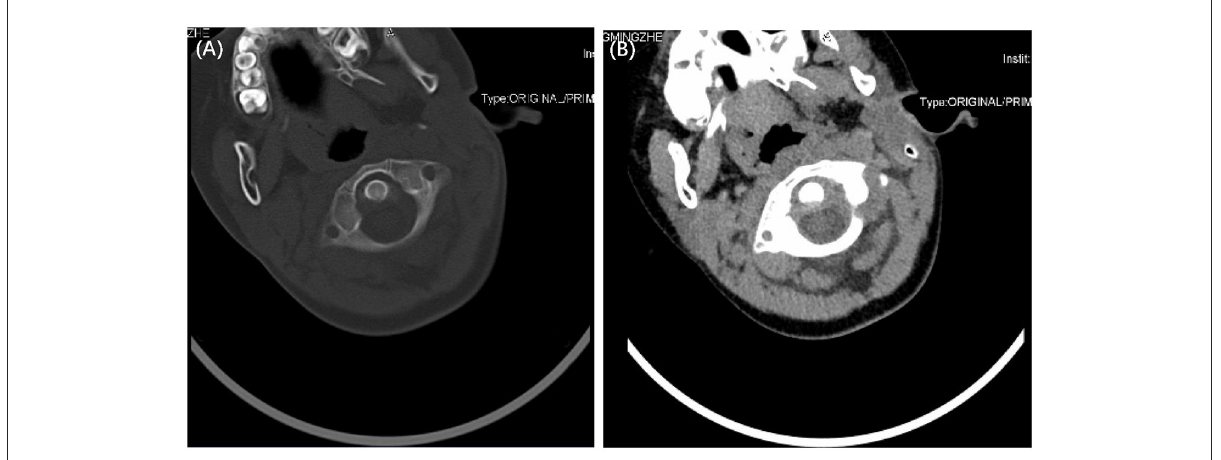
FIGURE1 A computed tomography scanning showed Type I atlantoaxial joint subluxation (A,B)